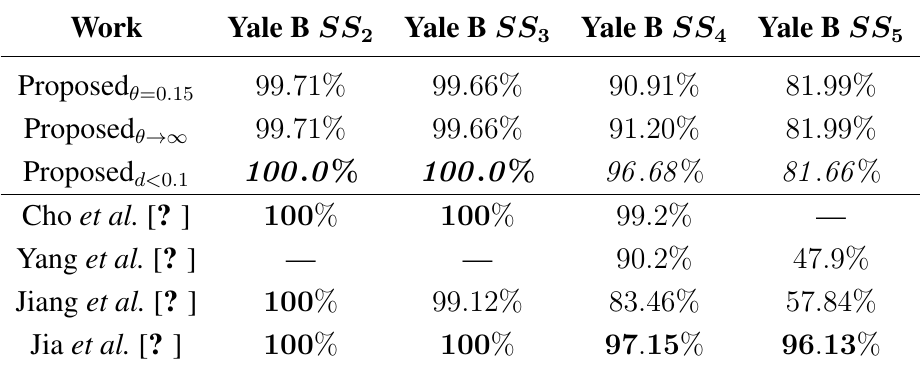
Table 3. Comparison between the obtained r some state-of-the-art